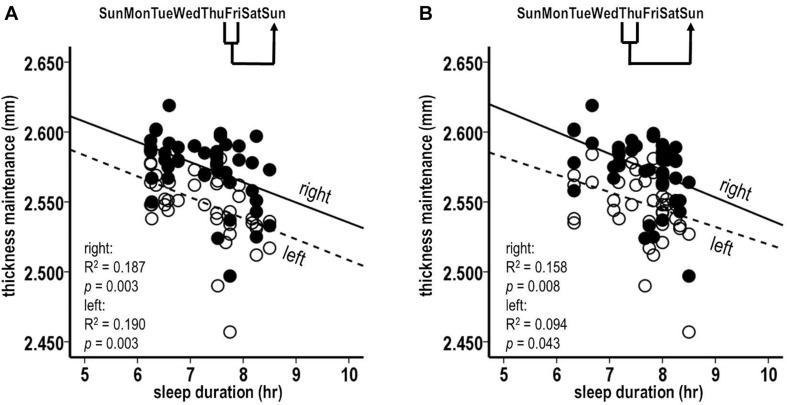
Laterality analyses of fluctuations in sleep durations for preceding Friday (A) and Thursday (B) nights vs. thickness maintenances for separate right (filled circles, solid regression lines) and left (unfilled circles, dashed regression lines) hemispheres on subsequent Sundays. Fluctuations in sleep durations for preceding Friday nights were significantly inversely related to subsequent thickness maintenances of the right and left hemispheres (A). Fluctuations in sleep durations for preceding Thursday nights were significantly inversely related to subsequent thickness maintenances of the right hemisphere, and had an inverse relationship trend to subsequent thickness maintenances of the left hemisphere (B).